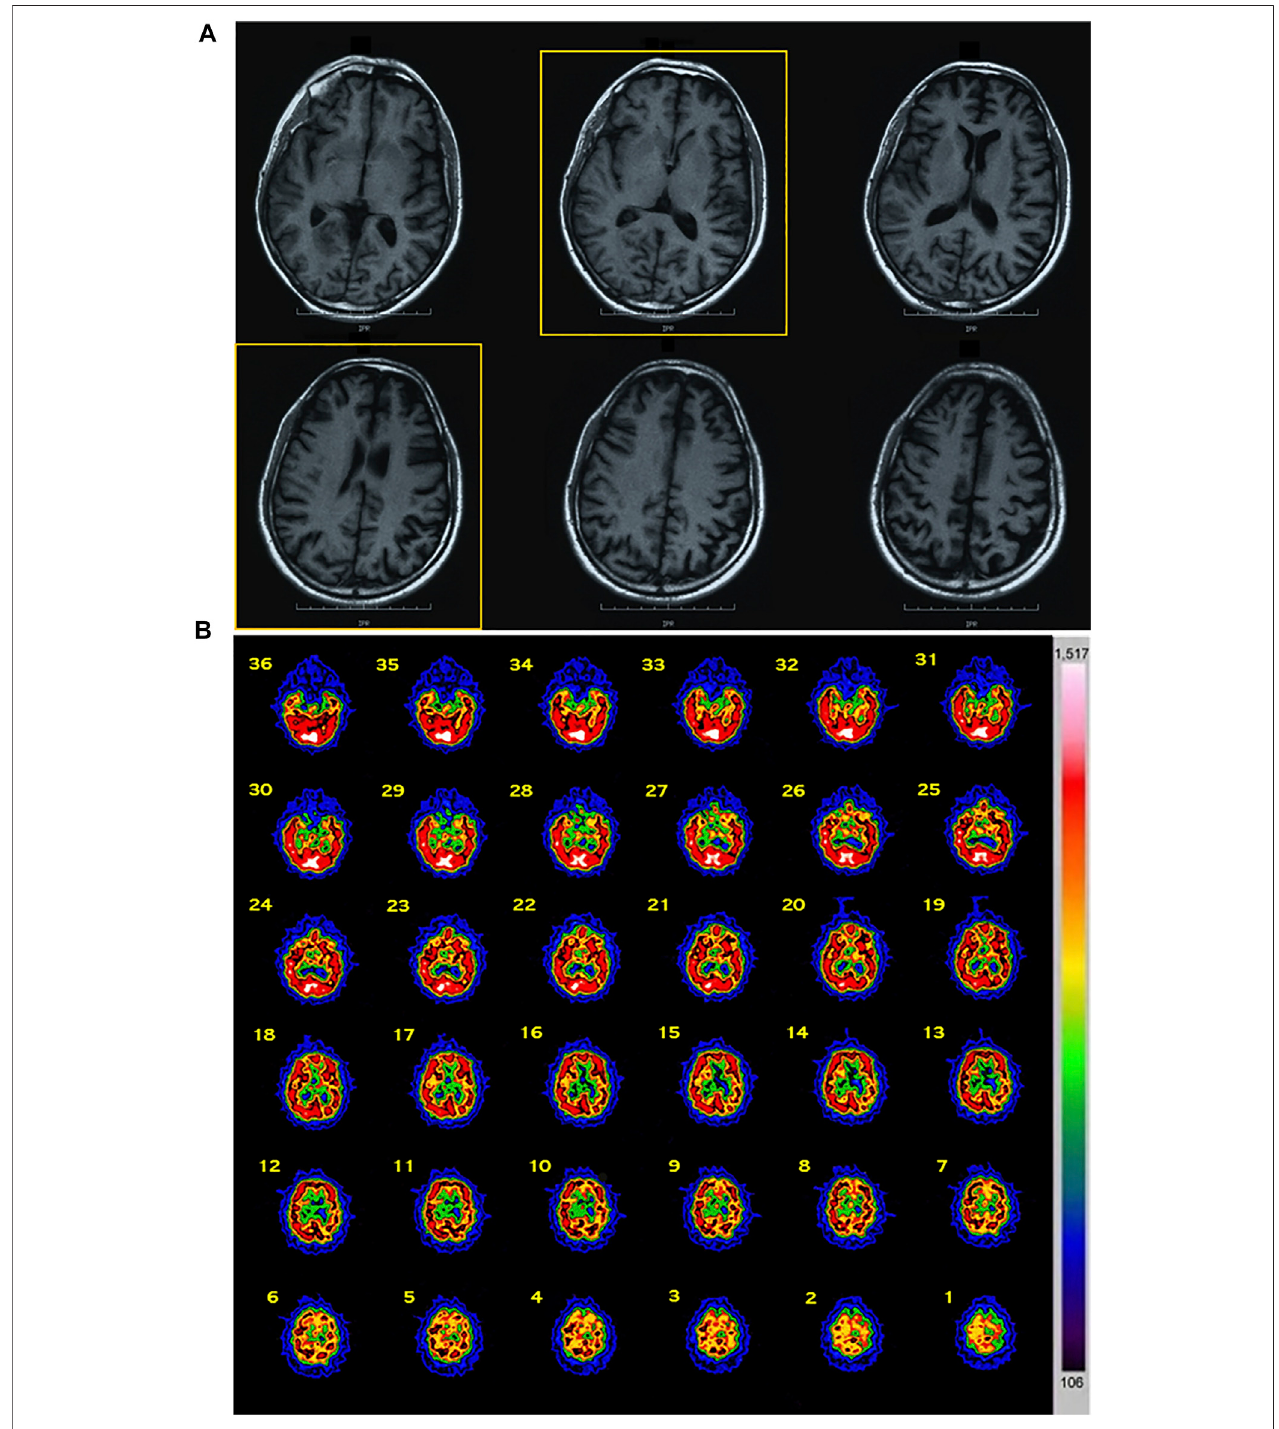
FIGURE 1 | Imaging data of the proband. (A) MRI data: diffuse cortical atrophy prominent in frontal and temporal regions was present. (B) SPECT data: a hypoperfusion was observed in frontal and temporal convolutions of the left hemisphere and upper frontal circumvolution of the right hemisphere. Abbreviations: MRI, magnetic resonance imaging; SPECT, single-photon emission computed tomography.